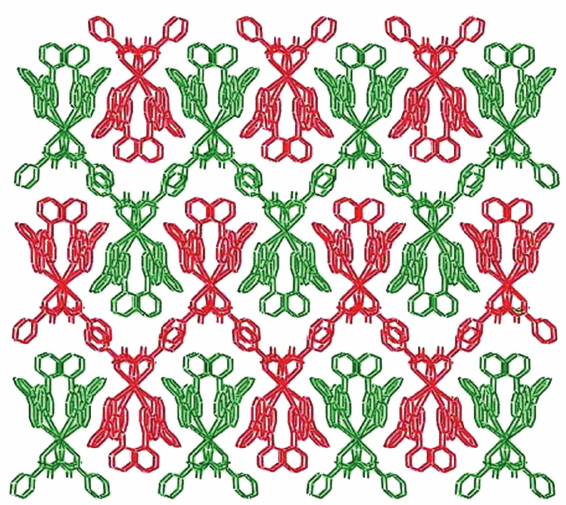
F 3: Perspective view of the complex down the a -axis, packing of mononuclear complex 1 forms 3D networks via